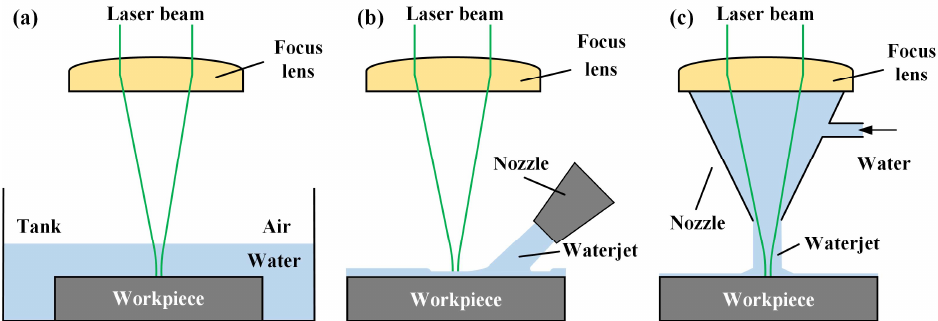
Figure 1. Schematic of water-assisted laser machining. ( a ) underwater laser machining; ( b ) off-axis waterjet assisted laser machining; ( c ) coaxial waterjet assisted laser machining.